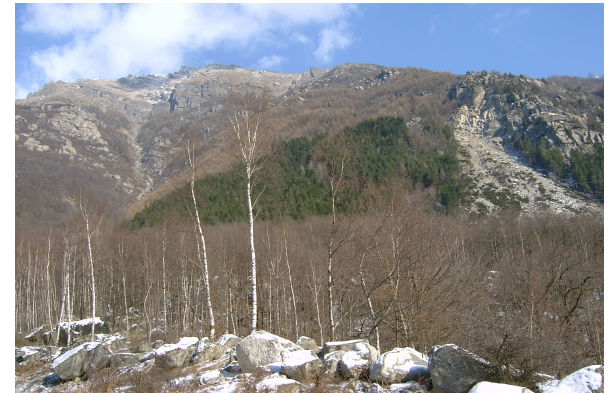
Figure 1. Sketch map of the study area (with main torrents and lakes). Figure 2. Frontal view of a minor catchment left to the Orco stream in which slope instability processes can be seen towards the right; these have been re-activated in October 2000. In the foreground, mountain birches can be seen, on the left side of the catchment, in a 75-year-old reforested area (photo 25 February